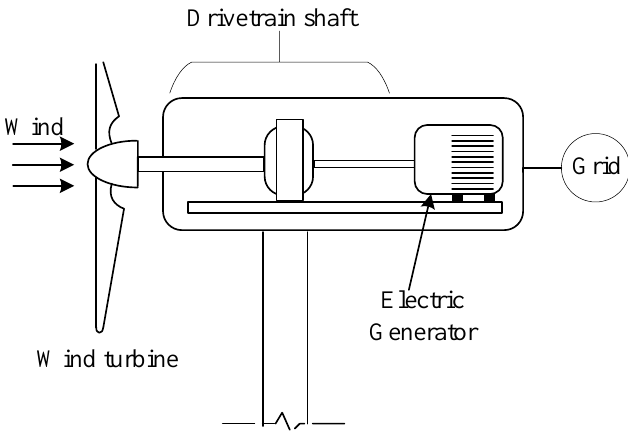
Figure 1. Schematic of the